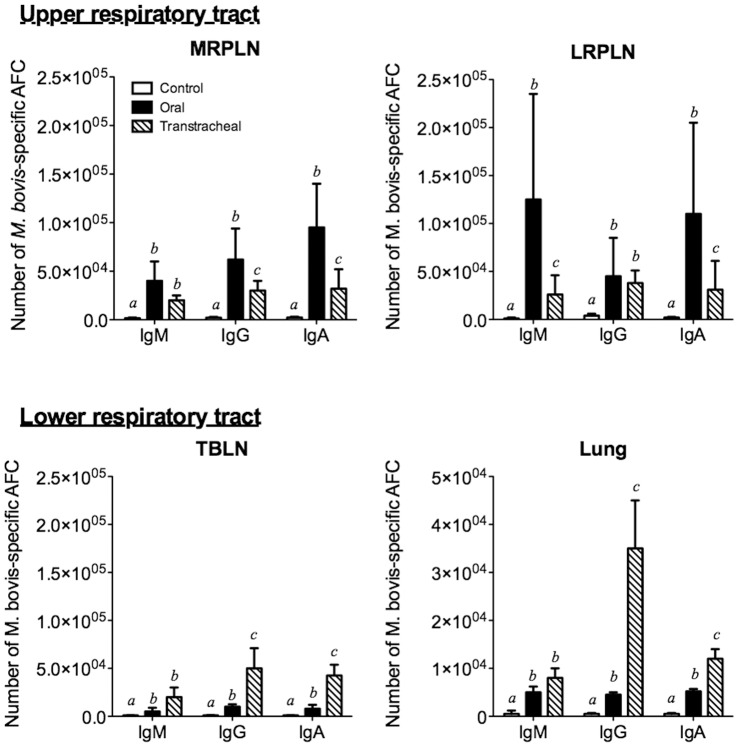
The upper respiratory tract had a greater increase in the number of mycoplasma-specific antibody-forming cells (AFC) than did the lower respiratory tract.ELISpot assays were performed on tissue collected at necropsy (14 days post infection except for one calf that was euthanized at 10 days post infection) from control calves (N = 5; white bars) and from calves inoculated by oral (N = 4; black bars) or transtracheal (N = 3; hatched bars) routes. Tissues from other calves in the study could not be analyzed due to low cell recovery. Cells were collected from Medial retropharyngeal lymph nodes (MRPLN), Lateral retropharyngeal lymph nodes (LRPLN), Tracheobronchial lymph nodes (TBLN) and Lung. The data for lymph nodes are represented as the mean ± SD of the total number of cells within that tissue. Data for the lungs are represented as the mean (± SD) of the number of cells/g of tissue. abcSuperscript letters indicate significant (P<0.05) differences in class-specific responses between groups.